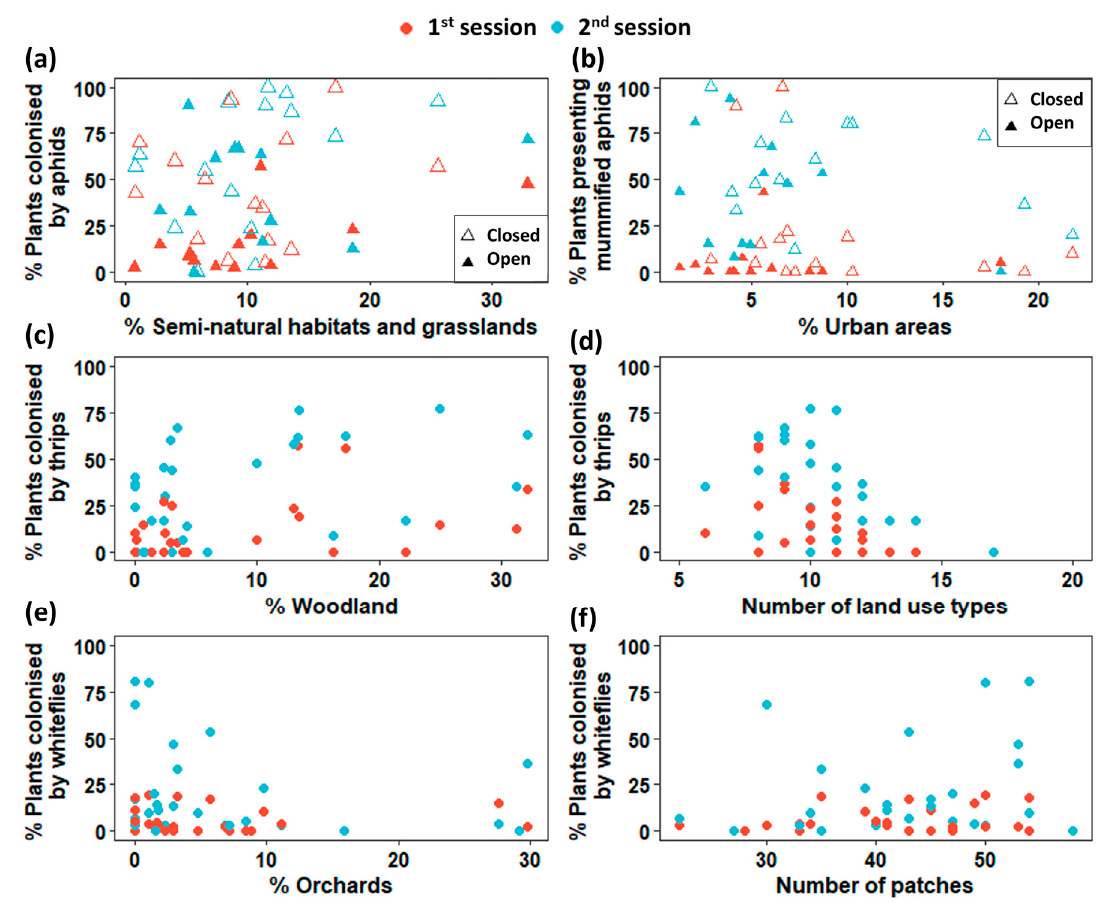
Figure 3. Effect of various landscape metrics on the colonization of greenhouse strawberry crops by pest and beneficial insects. ( a ) Percentage of plants colonized by aphids according to the percentage of semi-natural habitats and grasslands; ( b ) Percentage of plants presenting mummified aphids according to the percentage of urban areas; ( c ) Percentage of plants colonized by thrips according to the percentage of woodland; ( d ) Percentage of plants colonized by thrips according to the number of land use types; ( e ) Percentage of plants colonized by whiteflies according to the percentage of orchards; ( f ) Percentage of plants colonized by whiteflies according to the number of land use types. Red point represents the surveys in the first sampling session (April–May) and blue point in the second sampling session (June). Empty triangles represent closed greenhouses and solid triangles represent open greenhouses. When degree of openness of the greenhouses had no significant effect (see text and Table 3), points are represented by circles.